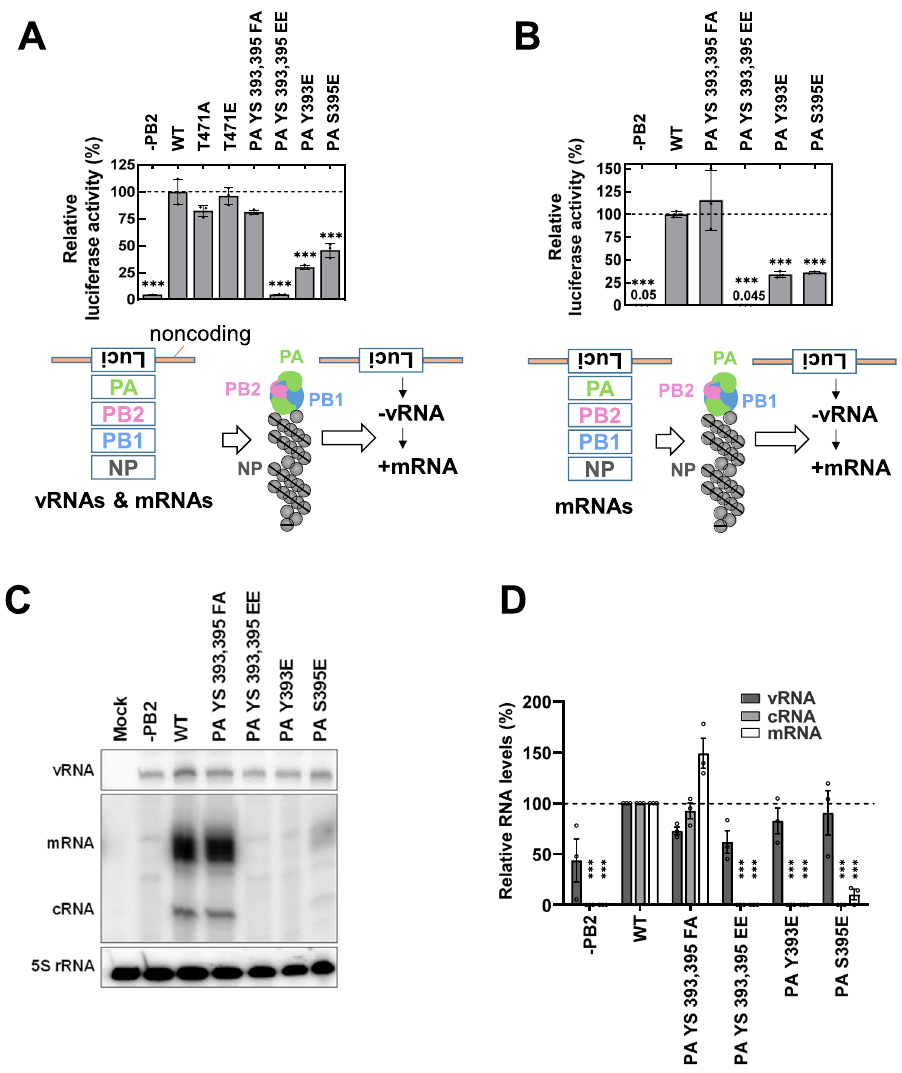
Figure 3. PA phosphorylation impairs RdRp activity. ( A ) The lower part shows the experimental set-up for the minigenome assay co-expressing the v/mRNAs of the viral PB2, PB1, PA and NP proteins. 293T cells were transfected to express the a Pol1-promoter driven vRNA-like transcript encoding the reporter gene together with pHW2000 plasmids allowing the expression of v- and mRNAs encoding the indicated viral proteins. One day later, cells were harvested and activities from Firefly luciferase (generated by vRNP polymerase activity using negative sense vRNA as a template) and Renilla luciferase (generated by a constitutive RNA polymerase II promoter and used for normalization) were determined. Activity by the WT vRNP was set to 100%, error bars represent SDs from three independent experiments. ( B ) The experiment was done as in (A) with the difference that the viral proteins were expressed from pCAGGS plasmids, not generating vRNAs, as schematically shown in the lower part. Extracts were used for determination of luciferase activity, the numbers show relative activity compared to the WT polymerase. ( C ) 293T cells were transfected with pCAGGS vectors directing the synthesis of the four proteins forming the vRNP together with the pPOLI-CAT-RT reporter plasmid, which generates a virus-like RNA as a first template. After isolation of RNA, the levels of cRNA, mRNA, rRNA (loading control) and the input vRNA (derived from a constitutive RNA polymerase I promoter) were determined by extension of 32 P-unlabeled primers, gel electrophoresis and autoradiography. ( D ) Data from three independent experiments performed in ( C ) were quantified and normalized to the 5S rRNA control. The RNA levels determined in cells expressing the WT vRNP were set to 100%. In all experiments, P values ≤ 0.001 are indicated by